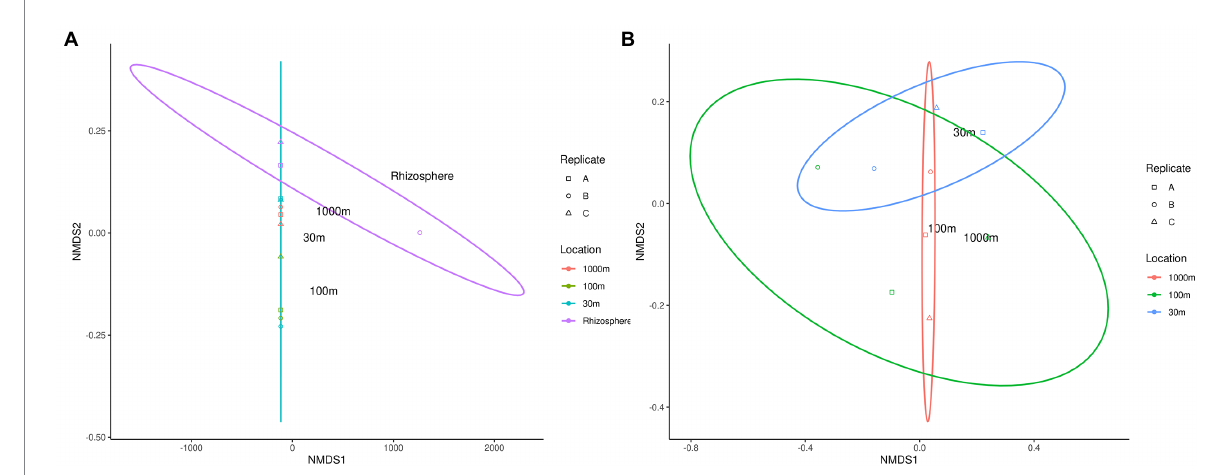
FIGURE 7 NMDS ordination of C. myrtifolia rhizosphere and nearby soil samples. Ordinations of the microbiome communities were produced by the Bray- Curts distance metric. (A) shows NMDS for the results for C. myrtifolia rhizosphere and nearby soil samples. Final ordination stress—0.107, Procrustes rnse, 0.002, and max resid—0.004. Data point colors correspond to distance from the C. myrtifolia plant. (B) shows the results with only the bulk soil samples and the rhizosphere removed to emphasize differences among those samples. Final stress = 0.130, Procrustes